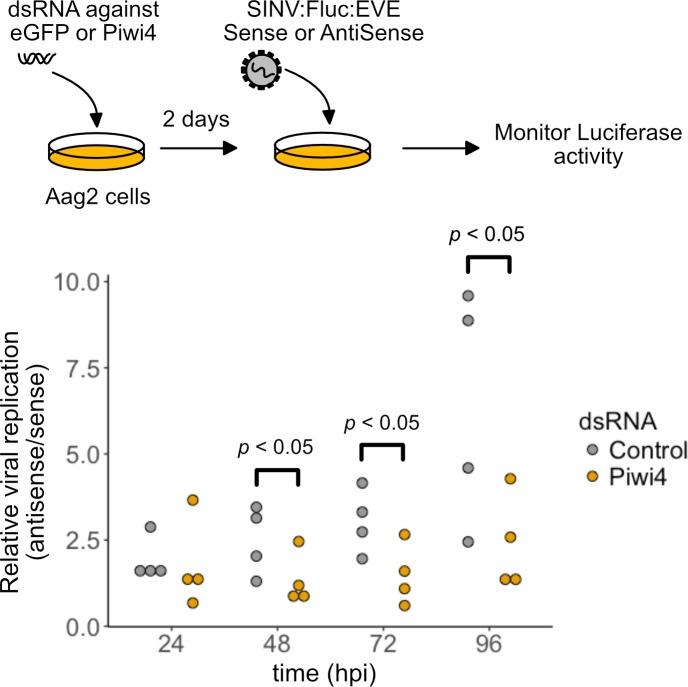
EVE-piRNA antiviral activity is mediated by Piwi4.Aag2 cells, transfected with dsRNA directed against Piwi4 or eGFP, were infected with a modified SINV strains (SINV:Fluc:EVE) expressing the Firefly luciferase reporter and carrying a 120 nt sense (S) or antisense (AS) sequence from an identified piRNA-producing EVE inserted within its 3’ UTR. Specific inhibition of the sense EVE target containing SINV:Fluc:EVE was assessed as the luciferase activity ratio of the SINV with the AS EVE over S EVE, at 24, 48, 72 and 96 hr post infection (hpi). The relative viral replication advantage of the AS vs S EVE containing virus was reduced in Piwi4 knock-down in Aag2 (Wilcoxon Signed-Rank test, n = 4 independent experiments).